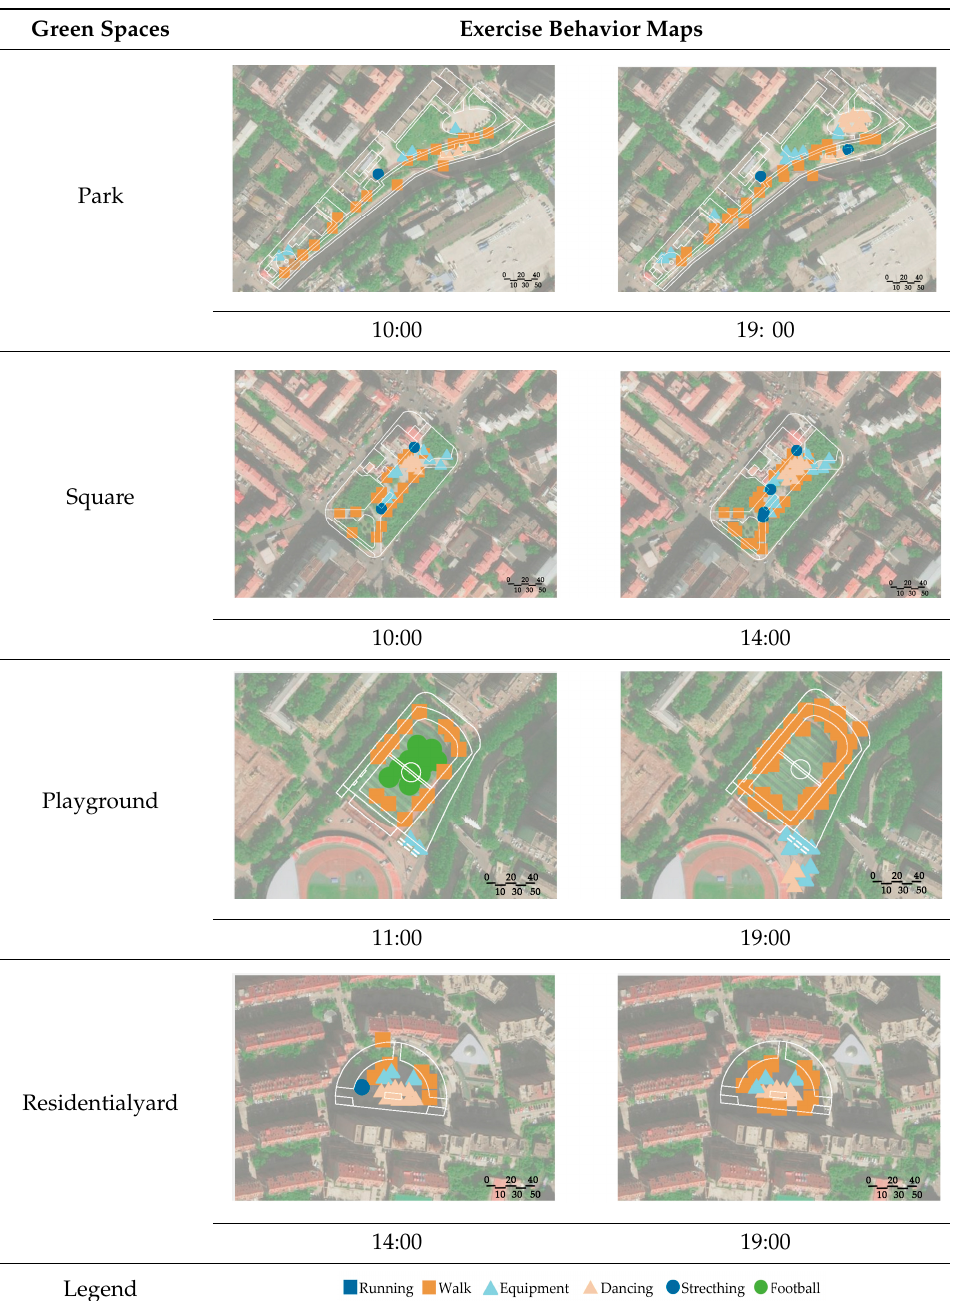
Figure 2. Number of exercisers at different time in the green spaces. (a) Number of exercisers at different time in the park; (b) number of exercisers at different time in the square; (c) number of exercisers at different time in the playground; (d) number of exercisers at different time in the residential yard. Table 9. Exercise behavior maps of the green spaces at the peak time points.